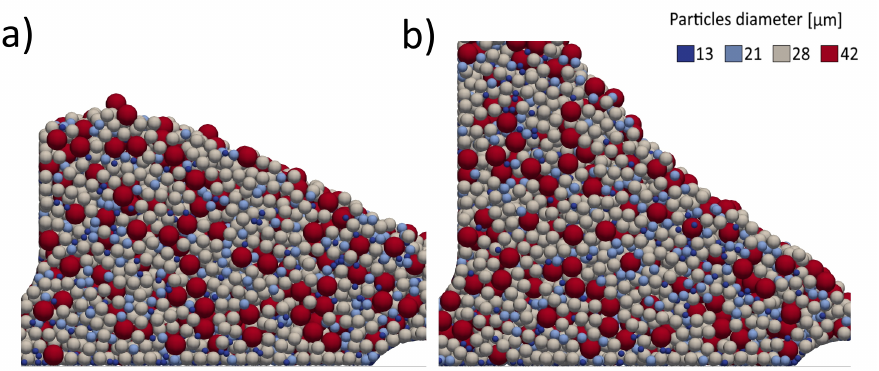
Figure 5. Dynamic angle of repose in the accumulation stage for two different speeds of the blade: ( a ) 20mm/s, ( b ) 100mm/s.